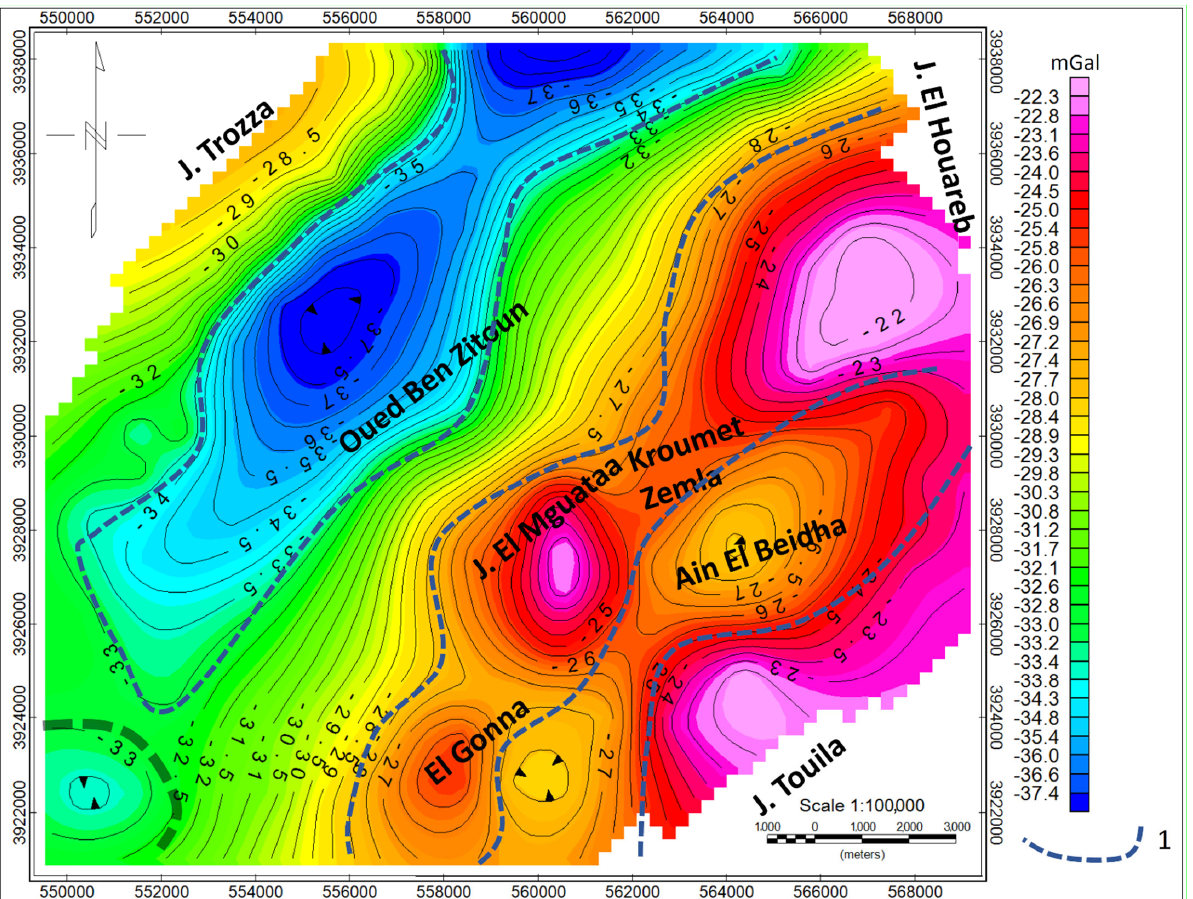
Figure 4. Interpreted Bouguer gravity map of the Ain El Beidha plain. (1) Limits of the major gravity anomalies. El Gonna–J. El Mguataa–Kroumet Zemla positive gravity axis composed of three prominent positive gravity anomalies, P1, P2, and P3 The Ain El Beidha negative gravity axis was comprised of two distinguished sub– negative anomalies, N3 and N4. The northwestern and southeastern borders of the Ain El